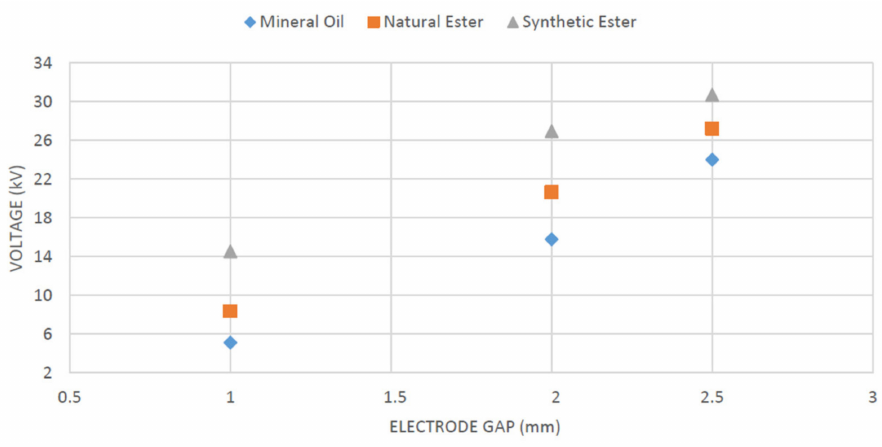
Figure 5. AC BDV—disc type